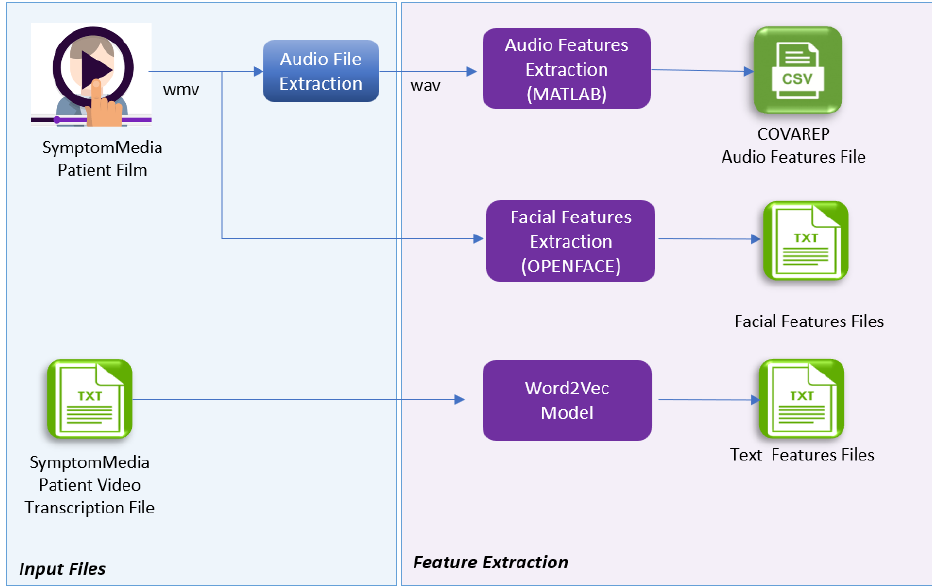
Figure 3. Feature extraction